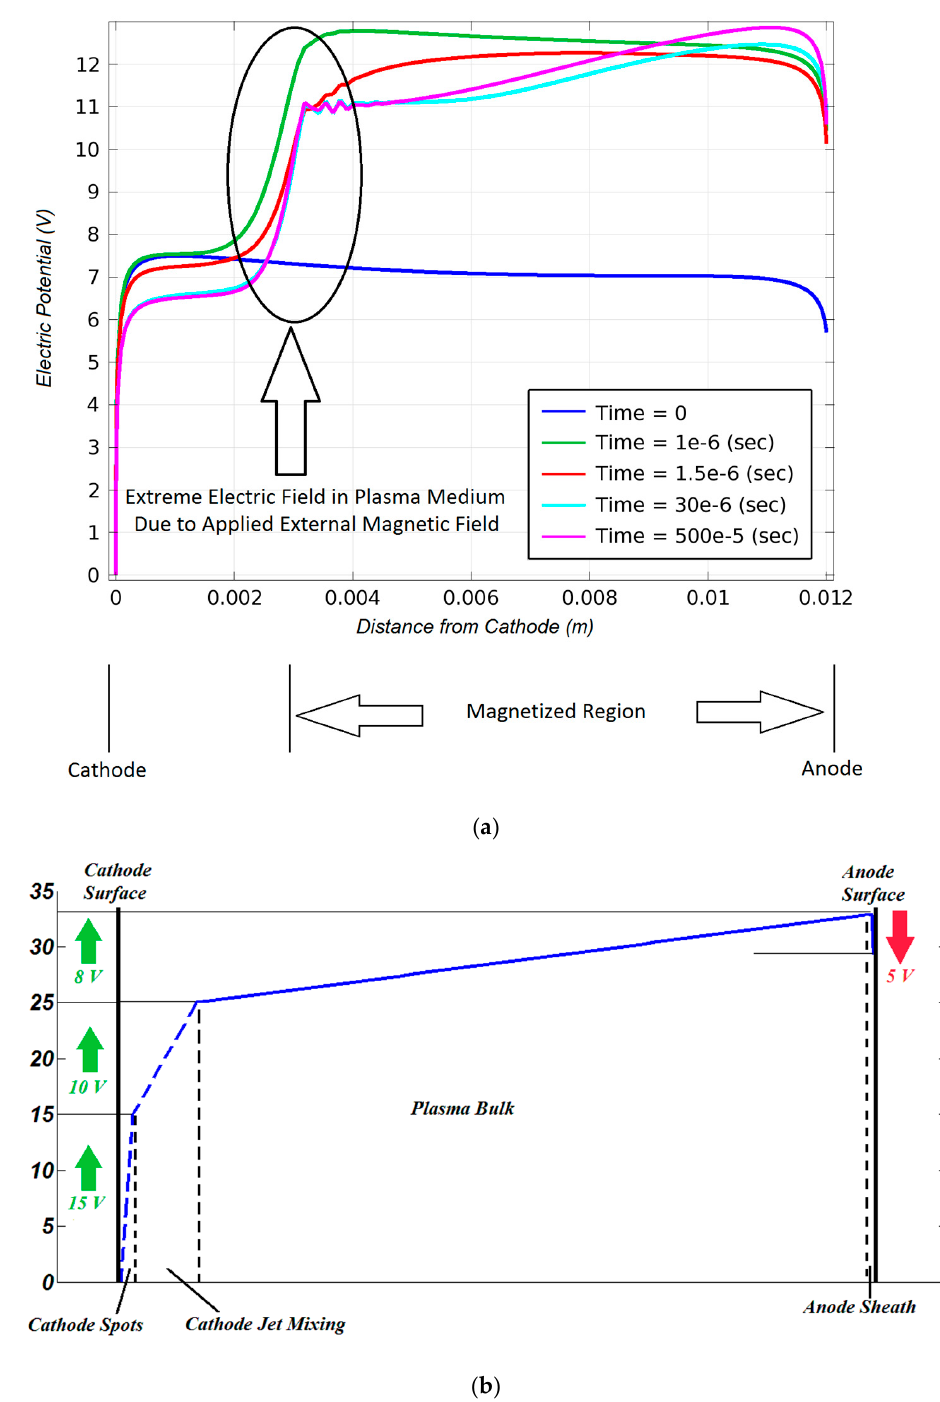
Figure 3. ( a ) Distribution of the electric potential across the symmetry axis of the plasma chamber at time steps: 0 µSec, 1 µSec, 1.5 µSec, 30 µSec, and 500 µSec after application of 20 mT UFTMF. ( b ) Distribution of the electric potential from the cathode to the anode according to the 15 kA arc imposed by the axial magnetic field [6].